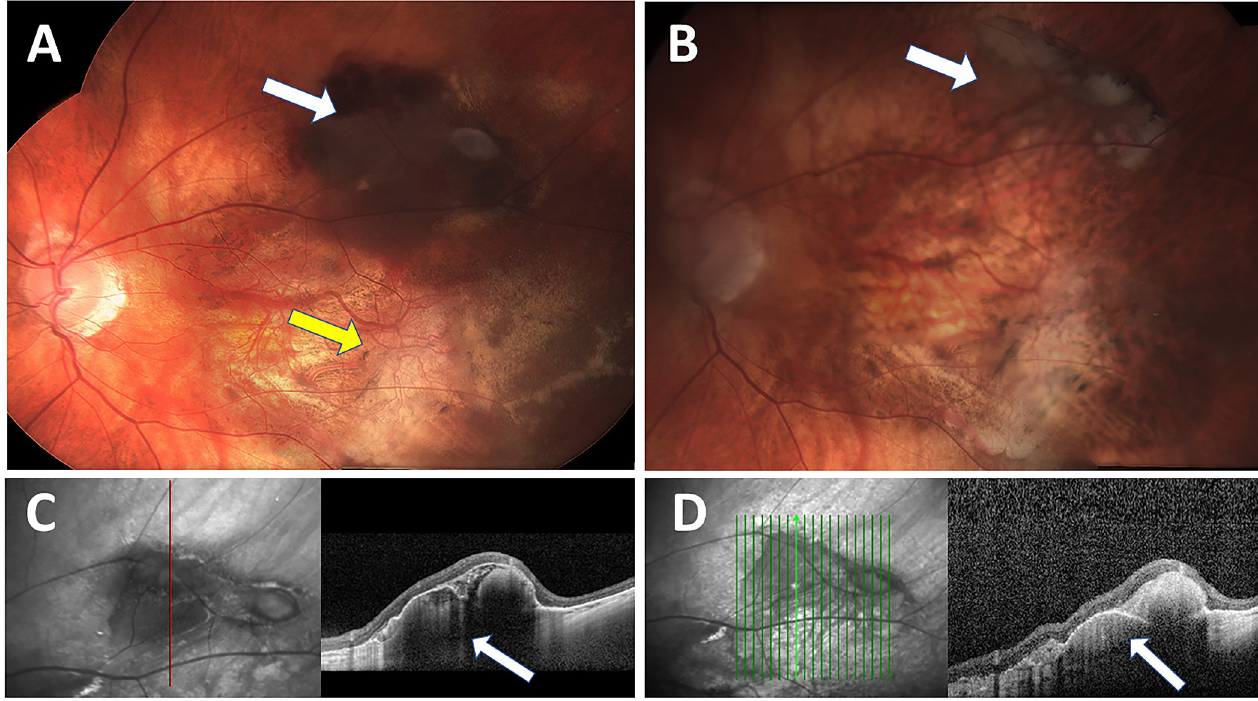
Fig 3. Clinical appearance and OCT findings before and after anti-VEGF treatment in a patient with macula threatening PEHCR. Color fundus photography of the same eye A before and B after 10 anti-VEGF intravitreal injections. A demonstrating a large elevated hemorrhagic lesion at the superior arcade consistent with hemorrhagic PEHCR (white arrow) old fibrotic lesion (yellow arrow), B resolution of the bleeding, clinical shrinkage of the lesion and residual atrophic changes (white arrow). C+D, OCT of the same eye at the level of the aforementioned lesion before and after treatment: C demonstrating a large hemorrhagic PED (white arrow) with no subretinal fluid. D After treatment the PED shrunk in size with a residual subretinal hyper-reflective layer consistent with scaring. No subretinal fluid is seen.